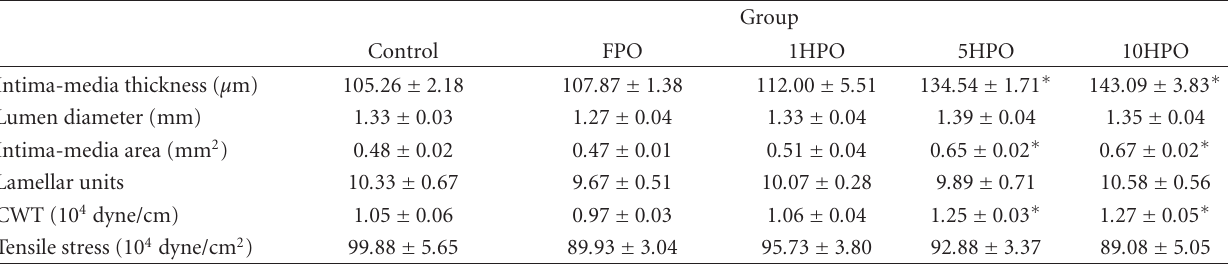
Table 2: Aortic morphometric measurements.